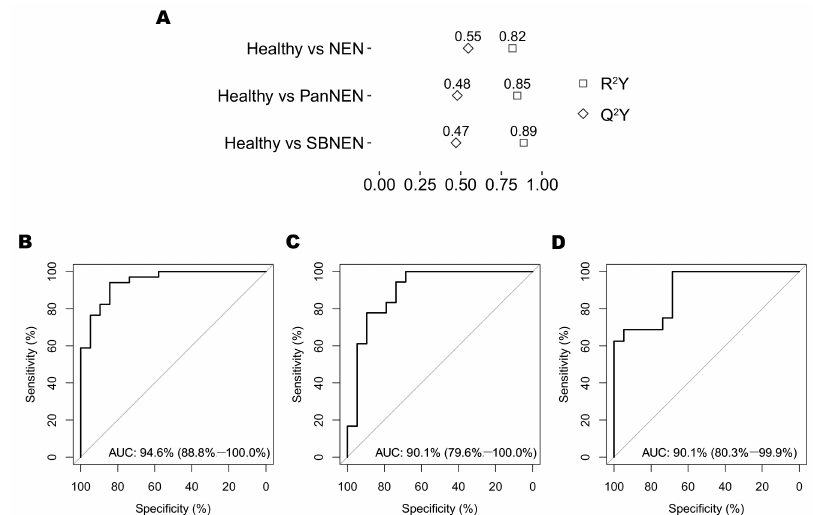
Figure 2. Ability of the OPLS-DA models to predict NEN status from healthy controls. ( A ) R 2 Y and Q 2 Y coefficients of the OPLS-DA models generated. ( B ) Receiver operating curves (ROC) and their associated area under the receiving operator curve (AUROC) values for Healthy vs. NEN (AUROC 0.94), ( C ) Healthy vs. PanNEN (AUROC 0.90) and ( D ) Healthy vs. SBNEN (AUROC 0.90). These demonstrate strong diagnostic utilities of the models for NEN and its subgroups.